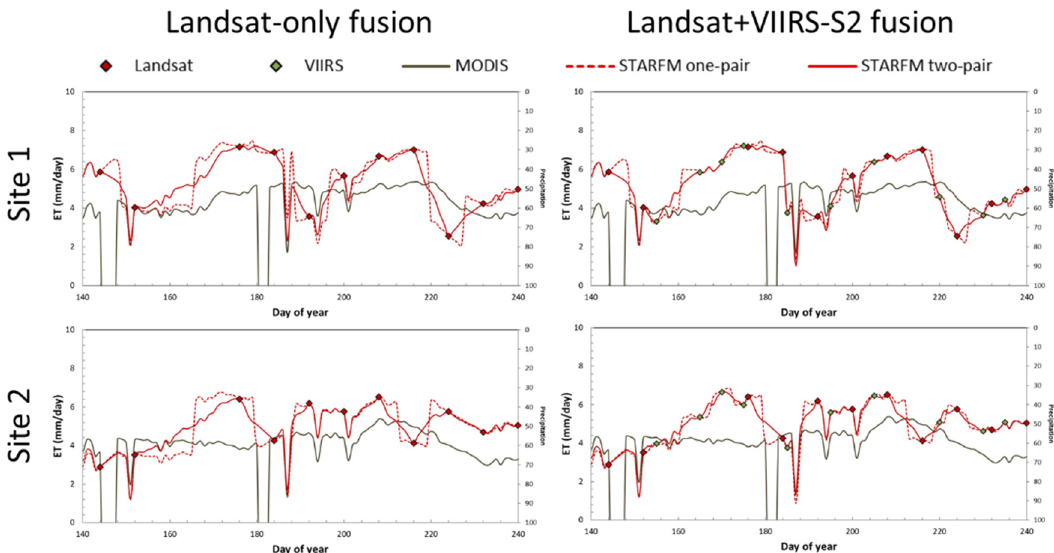
Figure A1. The fused 30 m daily ET time series during DOY 140–240 extracted at two vegetated fields (Site 1 and 2; see Figure A2) from the one-pair case (red dashed) and two-pair case (red solid), for both Landsat-only ( left column ) and Landsat + VIIRS-S2 fusion ( right column ).